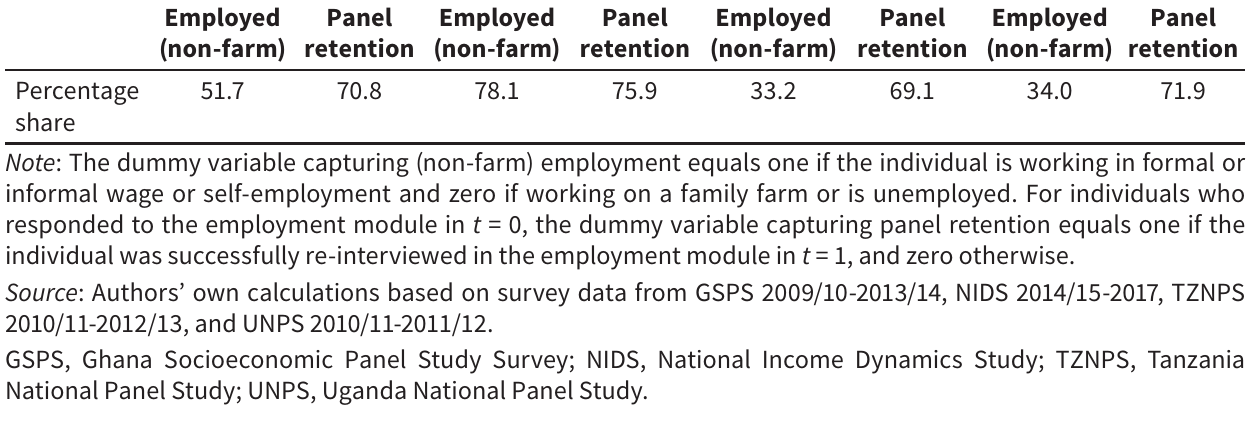
(Non-farm) employment and panel retention rates (%)